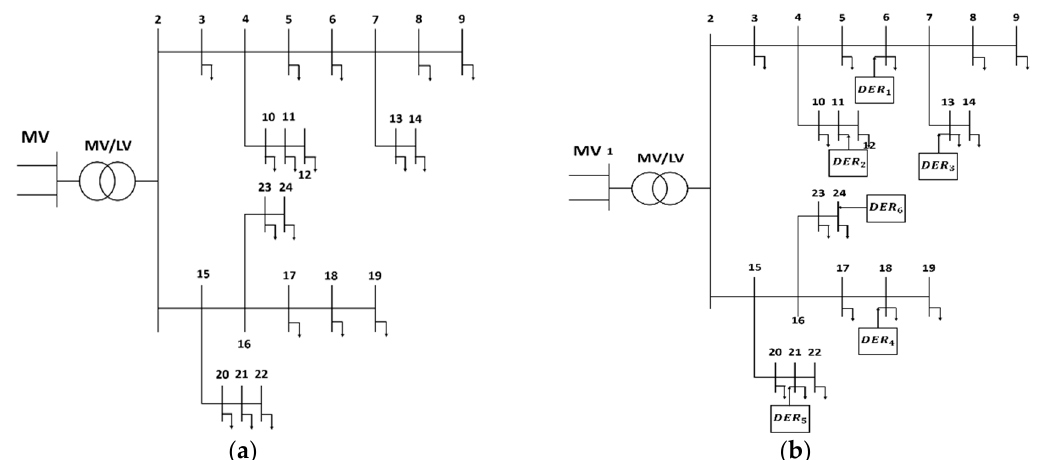
Figure 2. 24-nodes LV distribution network ( a ) network without DERs; ( b ) network with DERs.